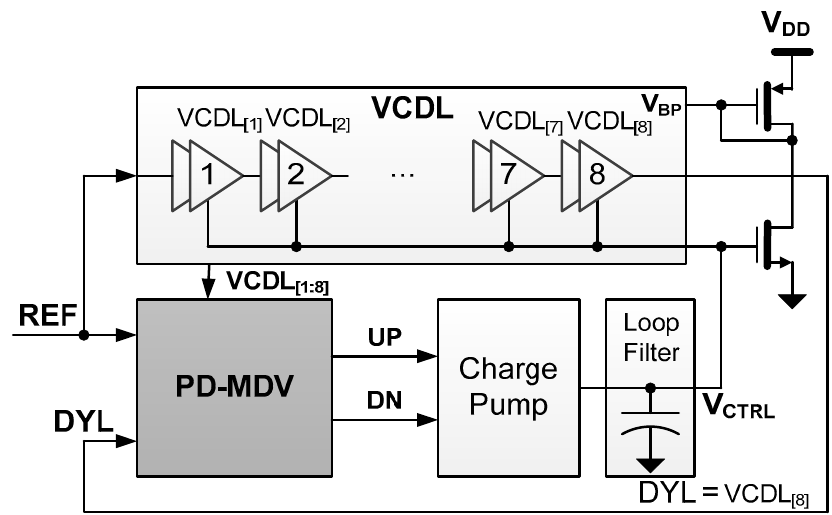
Figure 3. The structure of the proposed PD-MDV DLL.